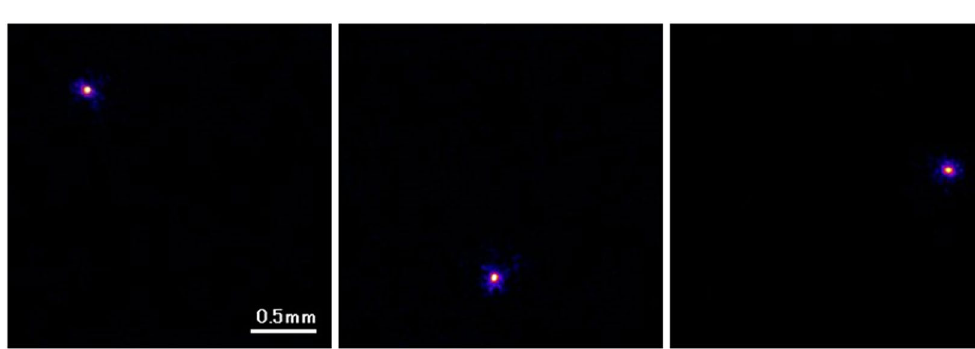
Figure 5. Optical images of transparent materials measured by imaging system with room light: LGSO scintillator block ( A ), GAGG pixel scintillator ( B ), and colored printed plastic sheet ( C ). Image without transparent material is also shown in ( D ). Black irregular lines mainly observed in left upper side of images are defects in fiber scintillator plate.